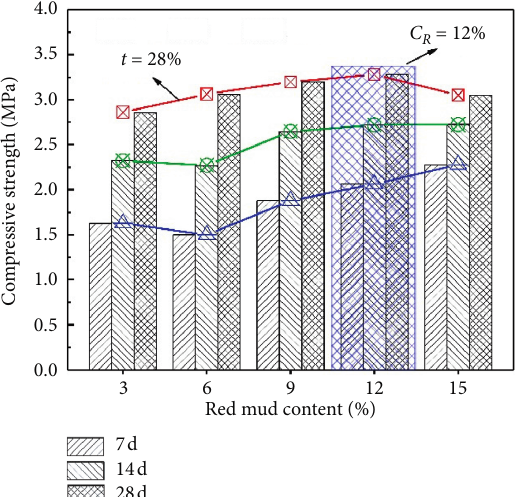
Figure 5: The relationship between compressive strength and red mud content.